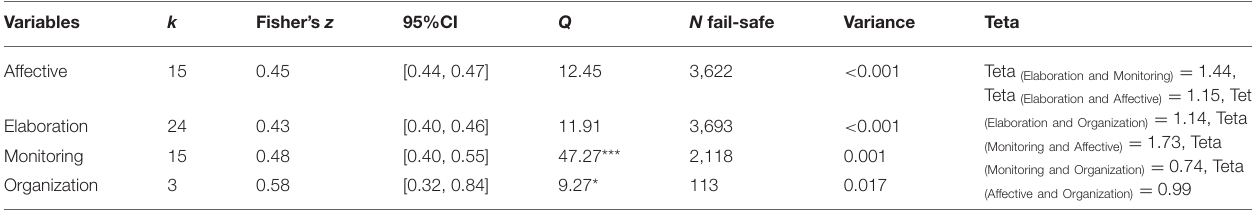
TABLE 2 | Reading strategy and reading comprehension of four